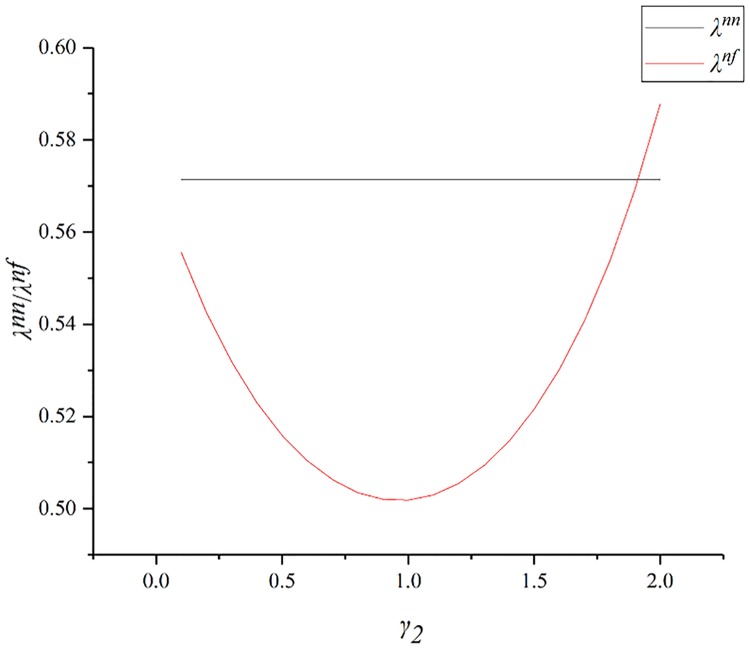
Impact of γ2 on λ.